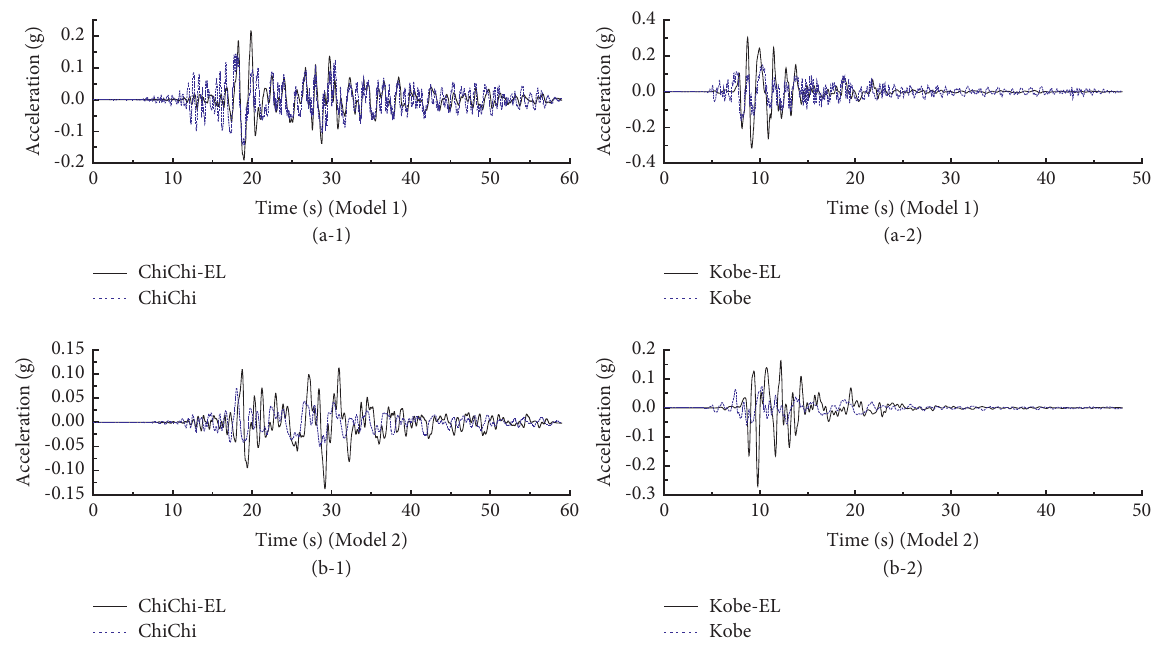
Figure 7: Surface time-domain acceleration response of (a) model 1 and (b) model 2.